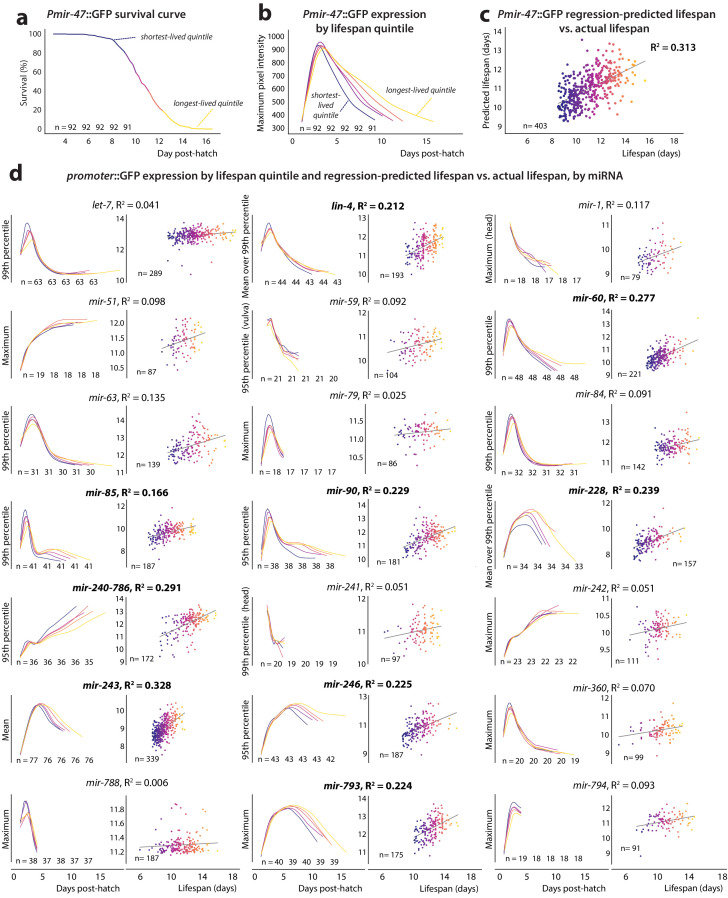
PmiRNA::GFP expression vs.future lifespan.(a) Survival curve for Pmir-47::GFP; spe-9(hc88) individuals pooled from five biological replicates. Animals are binned into color-coded quintiles based on eventual lifespan. The number of individuals in each quintile is indicated. (b) LOWESS regression of each quintile’s average Pmir-47::GFP expression (as measured by maximum intensity per individual at each timepoint) is plotted over time for the quintiles in panel a. (c) Joint regression of both the mean level of each individual’s Pmir-47::GFP expression between 5 and 8.5 days post-hatch, and the slope of that expression over that time, against future lifespan yields an R2 of 0.313. Each dot represents an individual animal and is color-coded based on lifespan. (d) Cohort-level expression timecourse and joint regression of slope and mean expression against future lifespan for all PmiRNA::GFP reporters. This mean and slope were measured across the optimal time window for each reporter’s correlation with future lifespan (specified in Table 2). Correlation coefficients > 0.15 are indicated by bolded text.